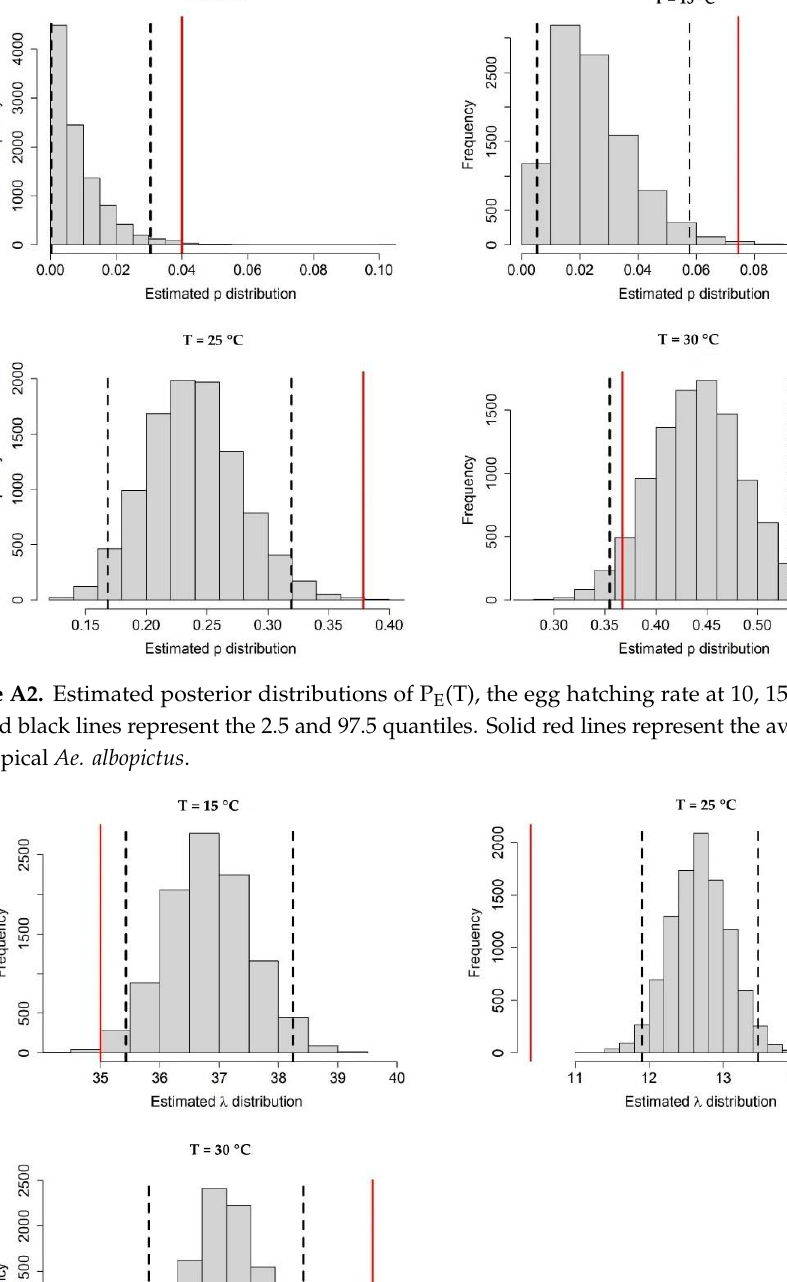
Figure A1. Estimated posterior distributions of Λ E (T), the average length of time (days) between immersion of eggs in water and hatching response at 15, 25, and 30 °C. Dashed black lines represent the 2.5 and 97.5 quantiles. Solid red lines represent the average value for subtropical Ae. albopictus .